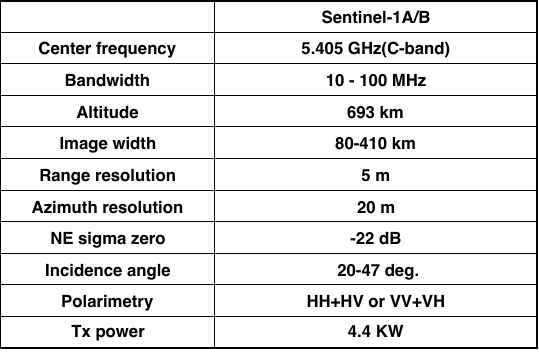
Table 1. Sentinel-1’s C-band SAR